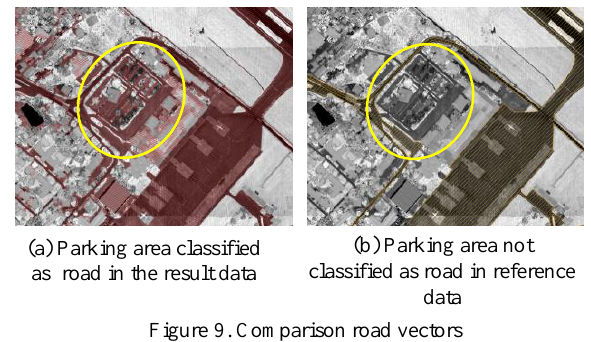
Figure 9. Comparison road